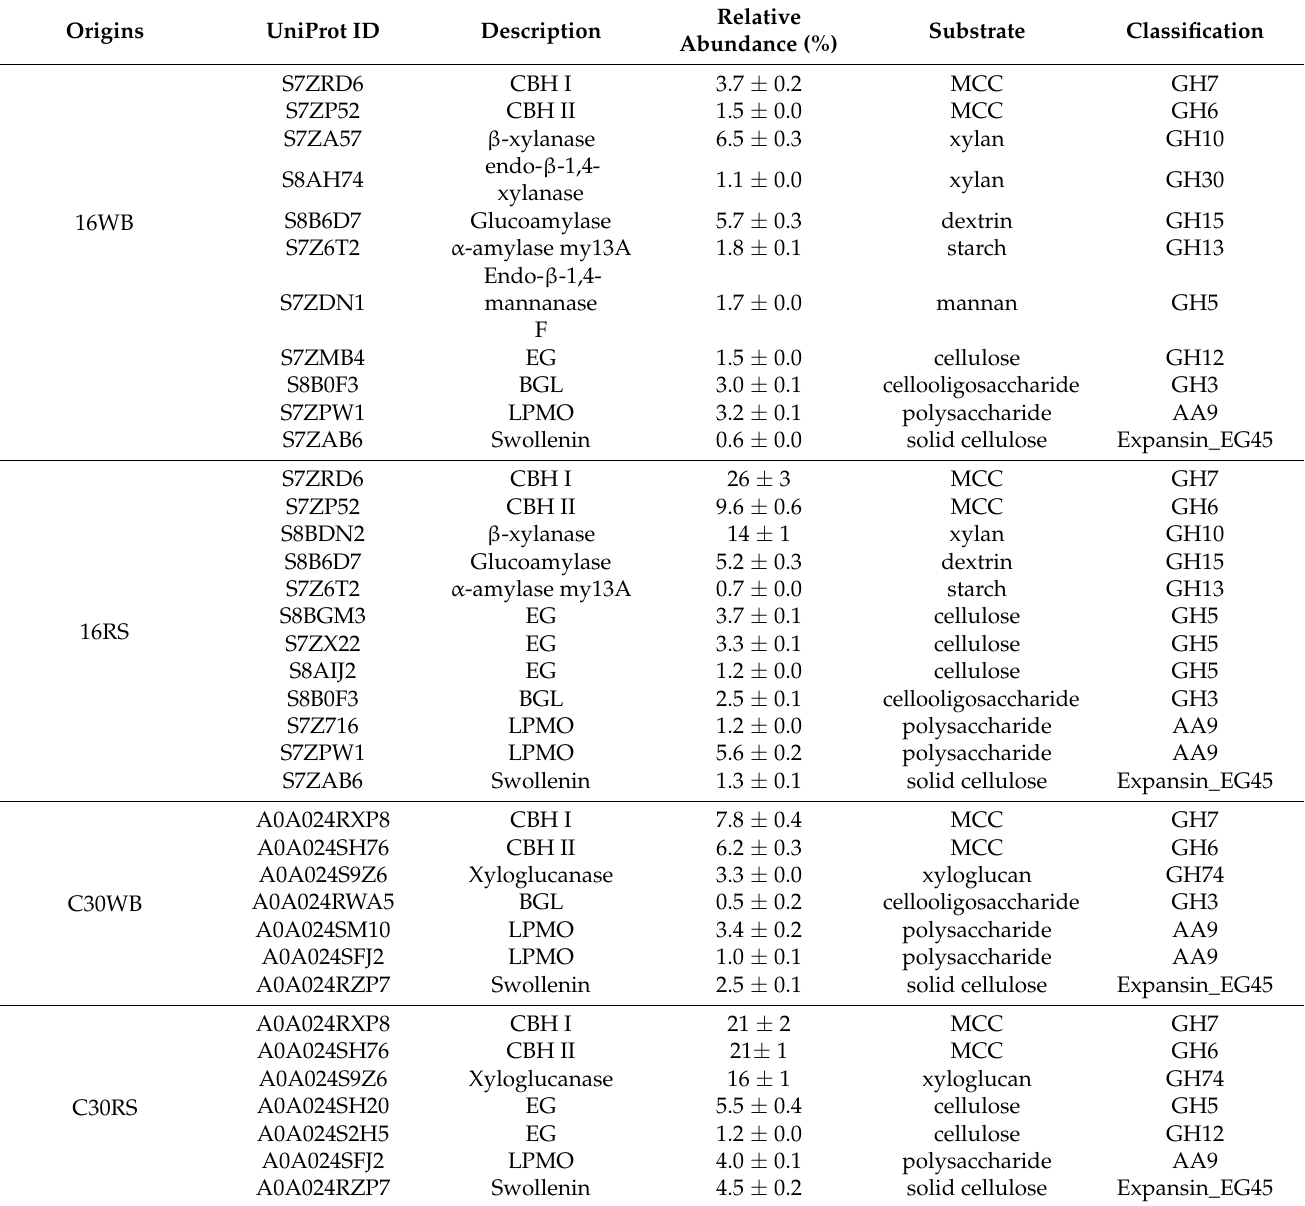
Table 5. Identities of the main